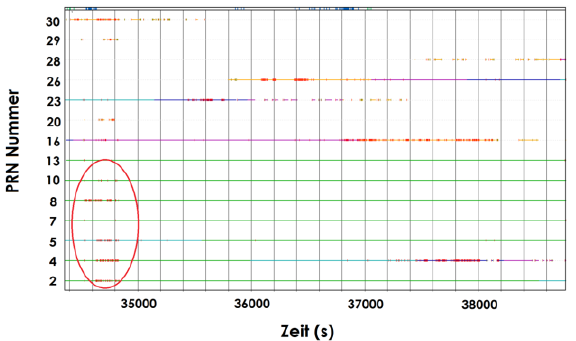
Figure 8. Cycle slips which were registered during data acquisition. The red points signalize the individual cycle slips. The red circle points on the cluster of cycle slips during the flight of the octocopter. The flight corresponds to the time interval from 34630 to 34850